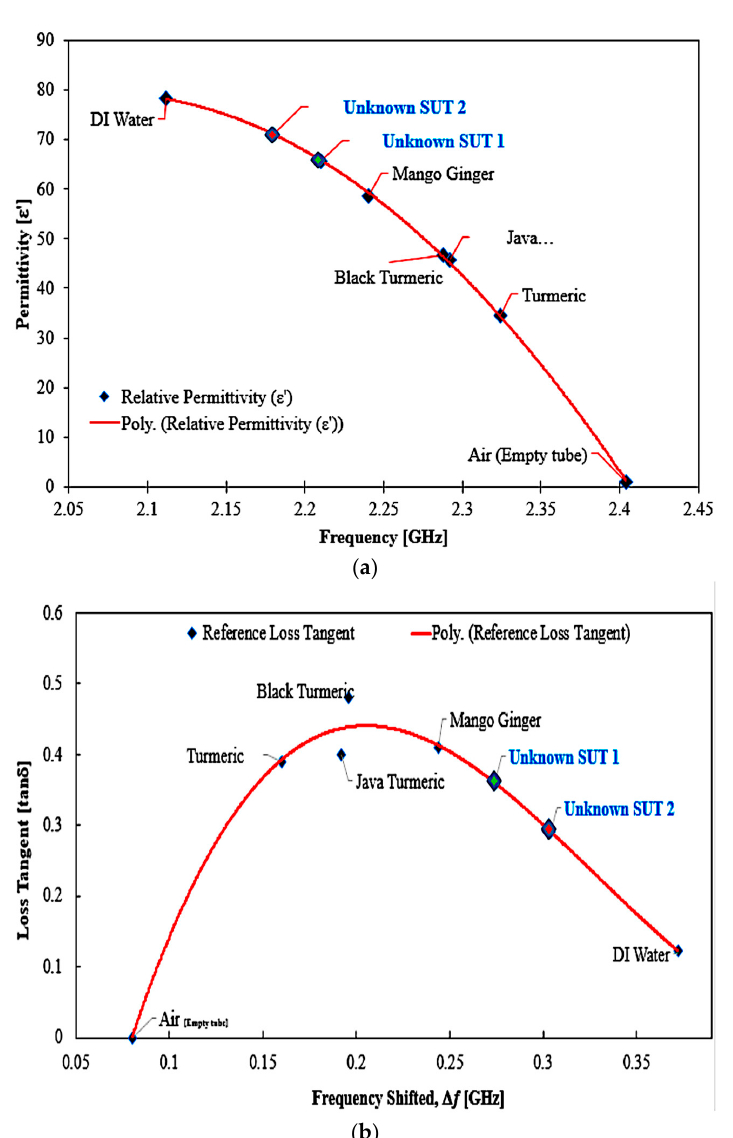
Figure 20. Unknown semi-solid SUTs: ( a ) real permittivity, ( b ) loss tangent versus resonant frequency extracted value, shown with known SUTs.